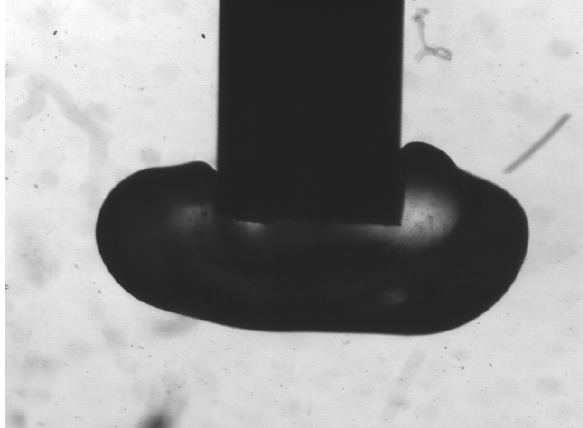
Figure 7d. Drop of PS (200,000 g/mol) in HDPE (t = 300 min) at 202 °C. Figure 7a. Drop of PS (200,000 g/mol) in HDPE (t = 0) at 202 °C.